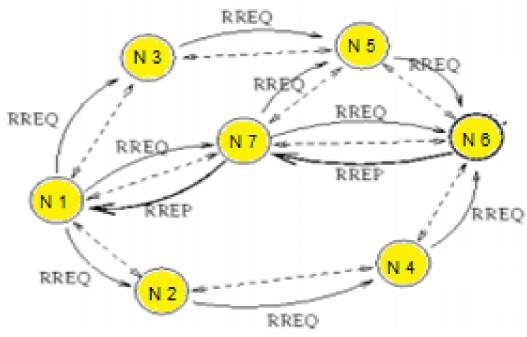
Figure 1. RREQ and RREP in AODV